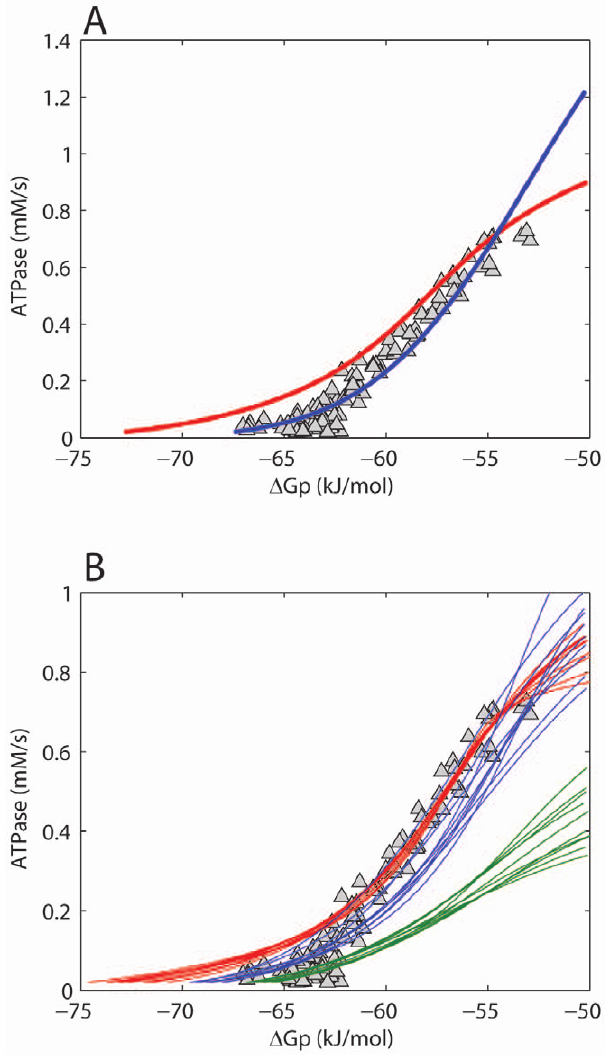
Figure 1. Testing model parameterization. Model predictions of the n G p - J p relation according to the initial model parameterization (red line) and after parameter optimization (blue line) ( A ). ( B ) shows the results of sampling of the model solution space by a Monte Carlo simulation approach. The 10 simulations with the best fit to all experimental data (blue lines), to high flux data points (ATPase . 0.4 mM/s, red lines) and to low flux data points (ATPase , 0.1 mM/ s, green lines) are shown. Experimental data points are indicated by n . Data were taken from [14].